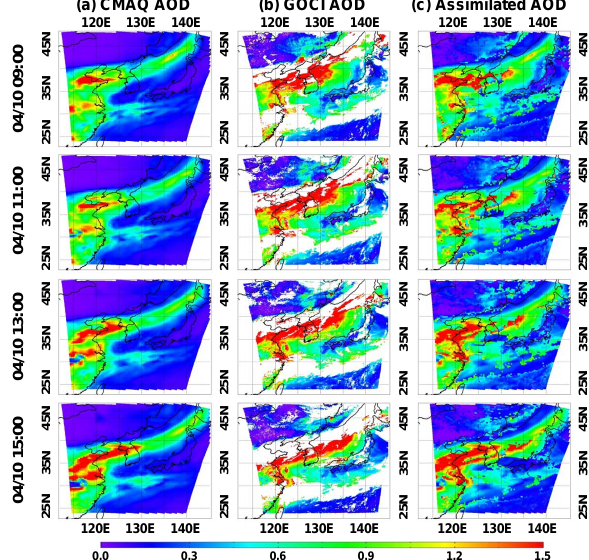
Figure 3. Spatial and temporal distributions of (a) CMAQ-simulated AOD (calculated via Chin et al. (2002)’s conversion algorithm), (b) GOCI-retrieved AOD (retrieved via Yonsei aerosol retrieval algorithm (Lee et al., 2010)), and (c) assimilated AOD with two-hour resolution over northeast Asia at 09:00, 11:00, 13:00, and 15:00 LST on 10April, 2011.